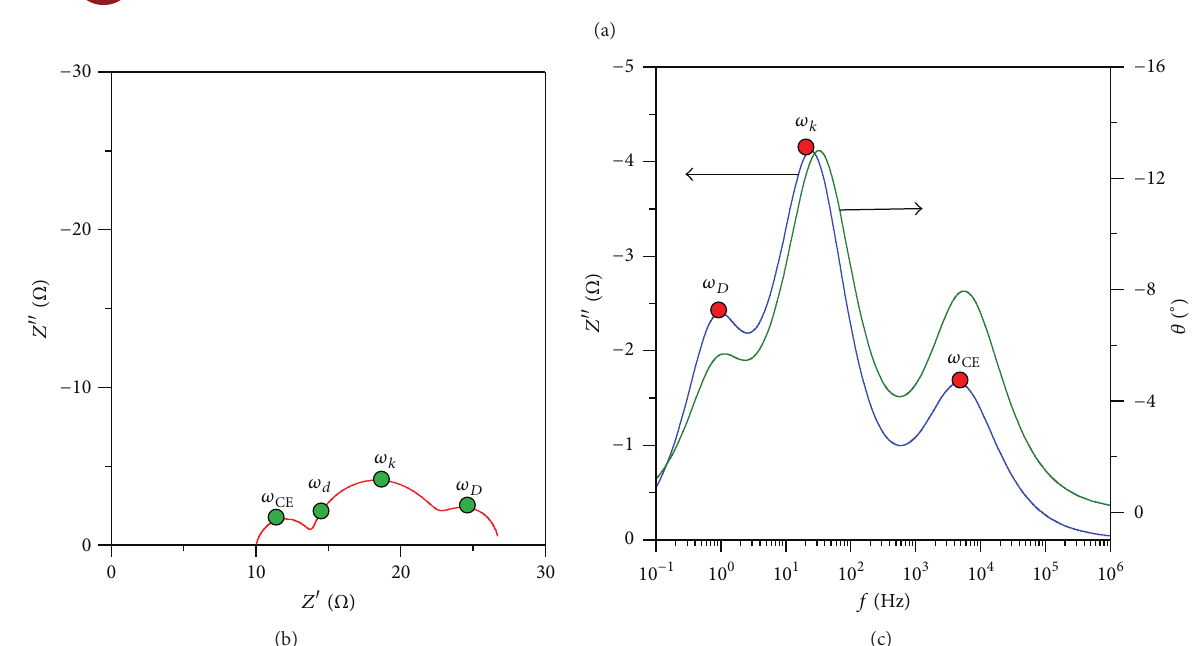
Figure 9: (a) Charge transfer kinetics involved in dye-sensitized solar cells where dark arrow shows loss mechanism: (1) injection of electrons, (2) diffusion of electrons in the TiO 2 , (3) regeneration of dye, (4) regeneration of redox mediator ( I 3− / I − ) , (5) diffusion of I 3− , (6) diffusion of I − , (7) back reaction of TiO 2 conduction band electrons with I 3− , (8) recombination of electrons with oxidized dye, and (9) back reaction of electrons from FTO to I 3− . (b) Typical impedance spectra of a DSSC presented in complex plane and (c) Bode imaginary (blue solid line) and phase (green solid line) plot. In the order of decreasing frequency, the characteristic frequencies 𝜔 charge transfer processes at the Pt/electrolyte interface, electron diffusion in the TiO 2 film, electron back reaction with oxidized redox species in the electrolyte, and diffusion of redox species in the electrolyte solution,